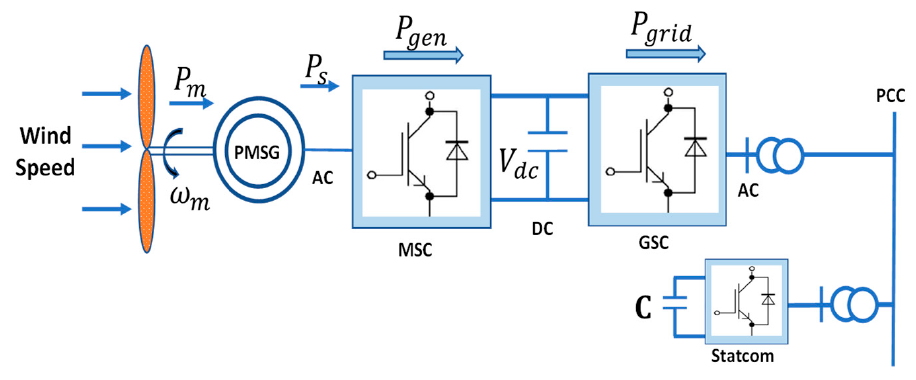
Figure 17. Wind turbine LVRT based on PMSG utilizing STATCOM.